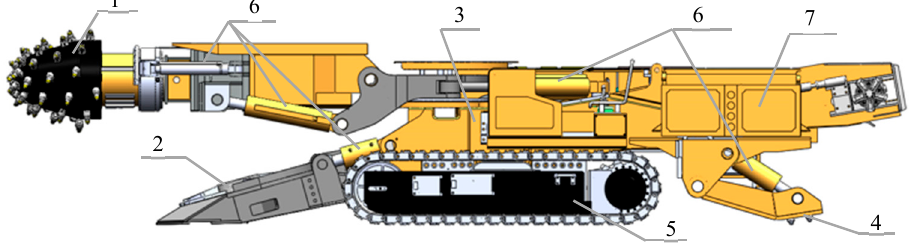
Figure 1. The structure of a boom roadheader. 1—cutting mechanism; 2—shovel plate mechanism; 3—frame; 4—conveyor; 5—walking mechanism; 6—hydraulic pressure system; 7—control system.